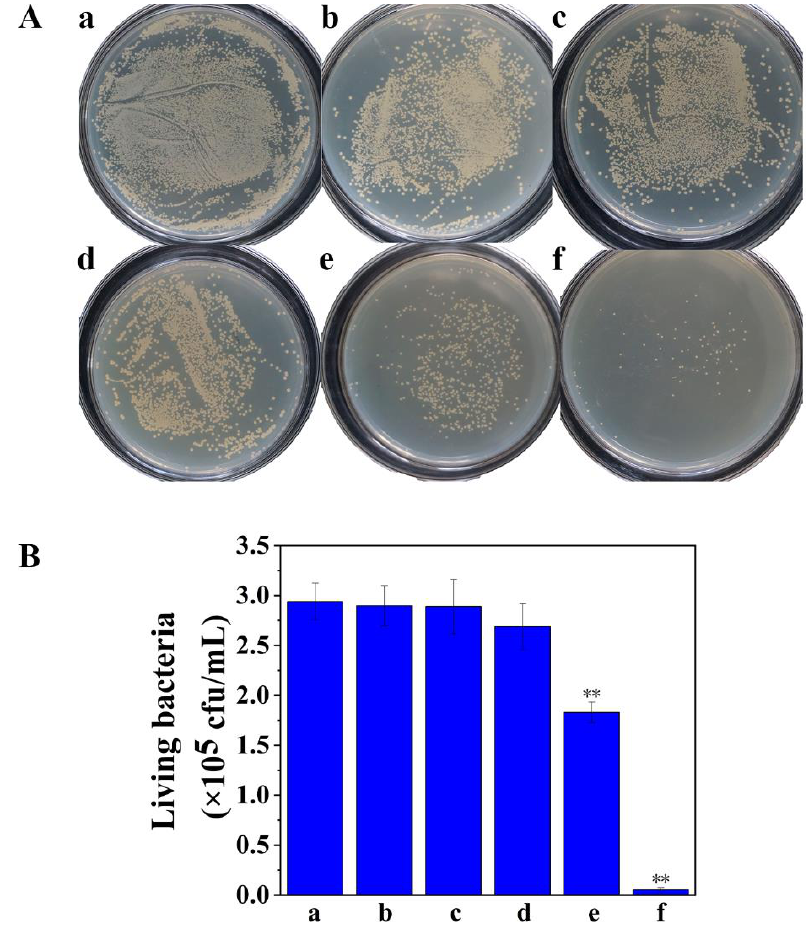
Figure 3. ( A ) The images of the cultured plates and ( B ) The concentration of viable bacteria of the samples treated under different conditions: ( a ) Control; ( b ) L; ( c ) AHMSN+L; ( d ) Cur+L; ( e ) AHMSN@Cur+L; ( f ) AHMSN@GA@PEI@Cur+L, (L: Blue light exposure for 5 min). The average viable bacteria concentrations are, respectively, 2.94 × 10 5 cfu/mL, 2.90 × 10 5 cfu/mL, 2.89 × 10 5 cfu/mL,